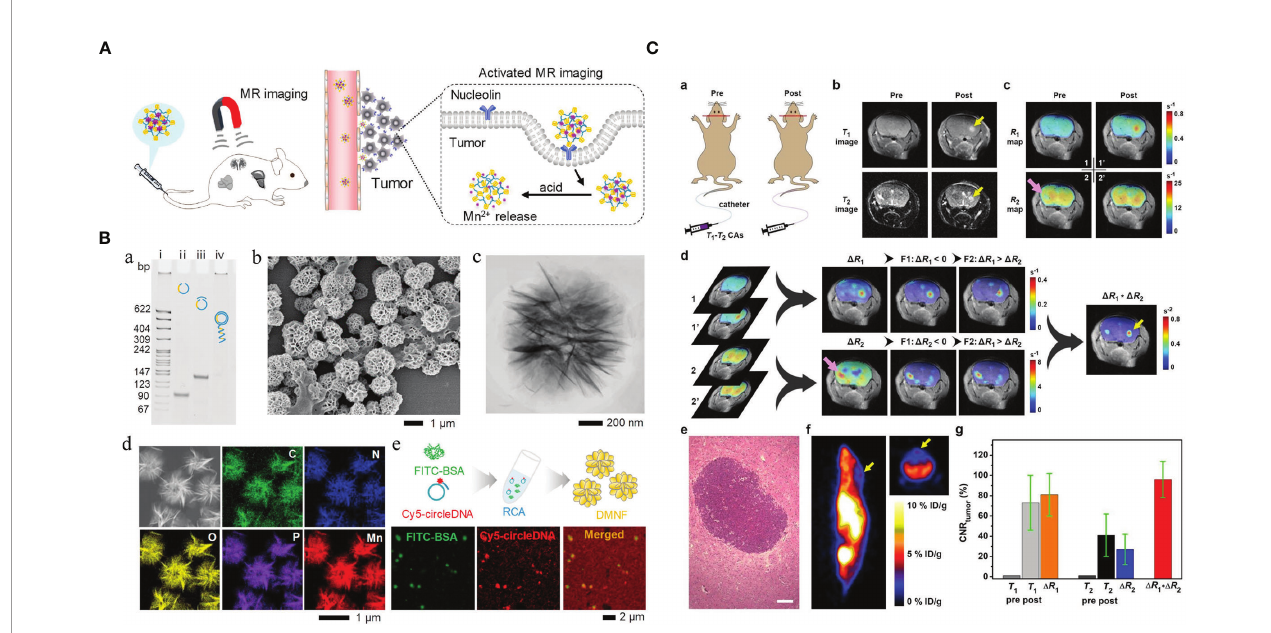
FIGURE 1 | Manganese (Mn)-based hybrid nanomaterials as imaging agents and their application in tumor. (A) Diagram of the enhanced MRI of DNA-Mn-based nano fl ower (DMNF)-treated tumor-bearing mice (27). (B) Preparation and characterization of DMNF imaging agents (27). (C) Representative T1- and T2-weighted images of mouse brain at pre- and post-contrast points. T1-T2 dual-modal MRI in brain tumor model through the synthesized MRI contrast agents, NOTA conjugated NEB chelating with Mn 2+ (Mn-NEB) and BSA (Mn-NEB+BSA) (28). DMNF, DNA-Mn-based nano fl ower; NOTA, N, N ’ , N ’’ -triacetic